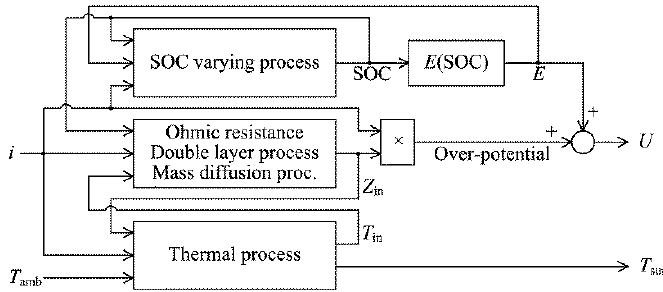
Figure 3. Relationship between different battery dynamics.